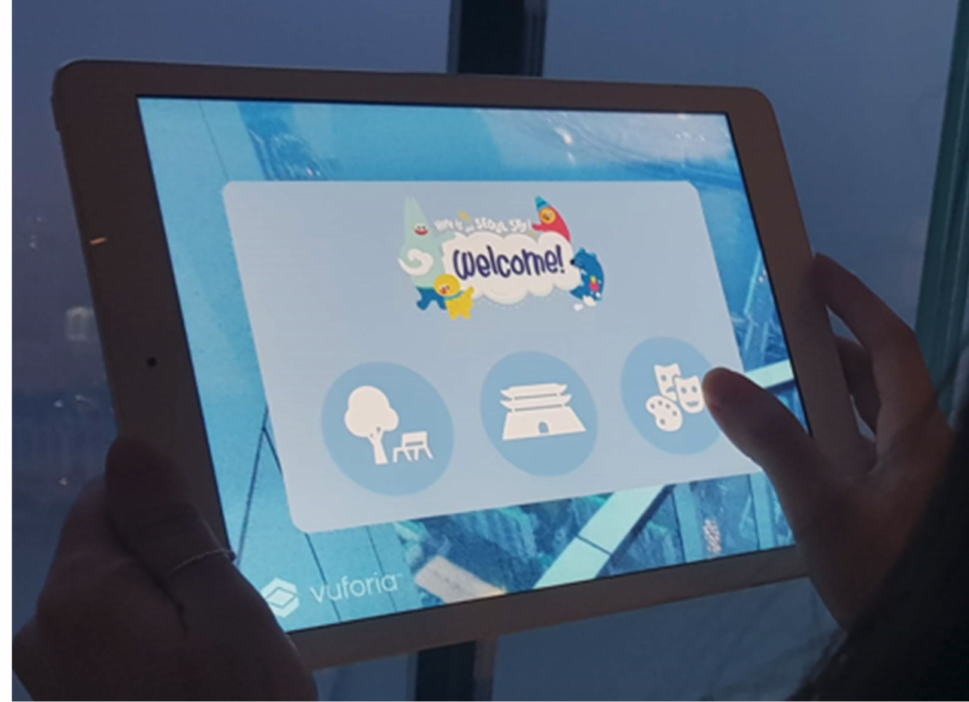
Figure 4. On the home screen, a user can select one of the categories of tourist attractions that can be viewed from the observatory: nature, ruins, or